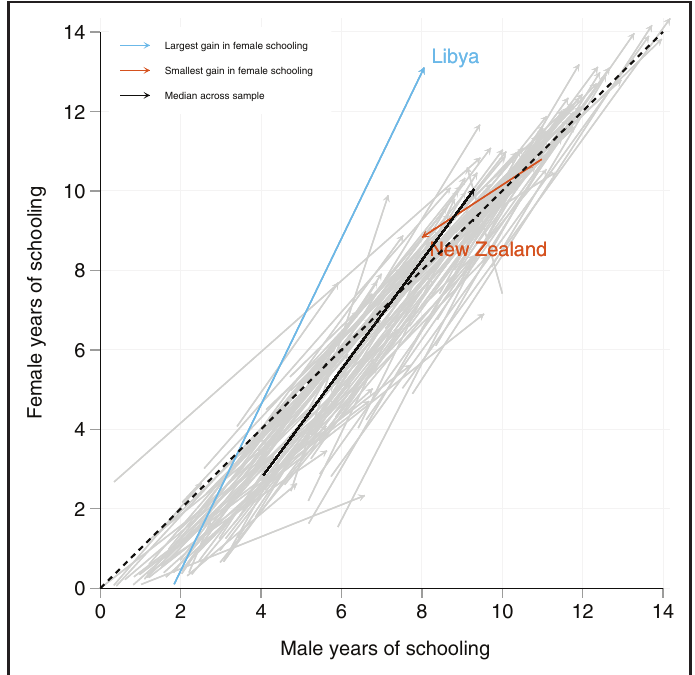
Change in Average Schooling Years between 1960 and 2010 for Younger Cohort. LibyaLibya